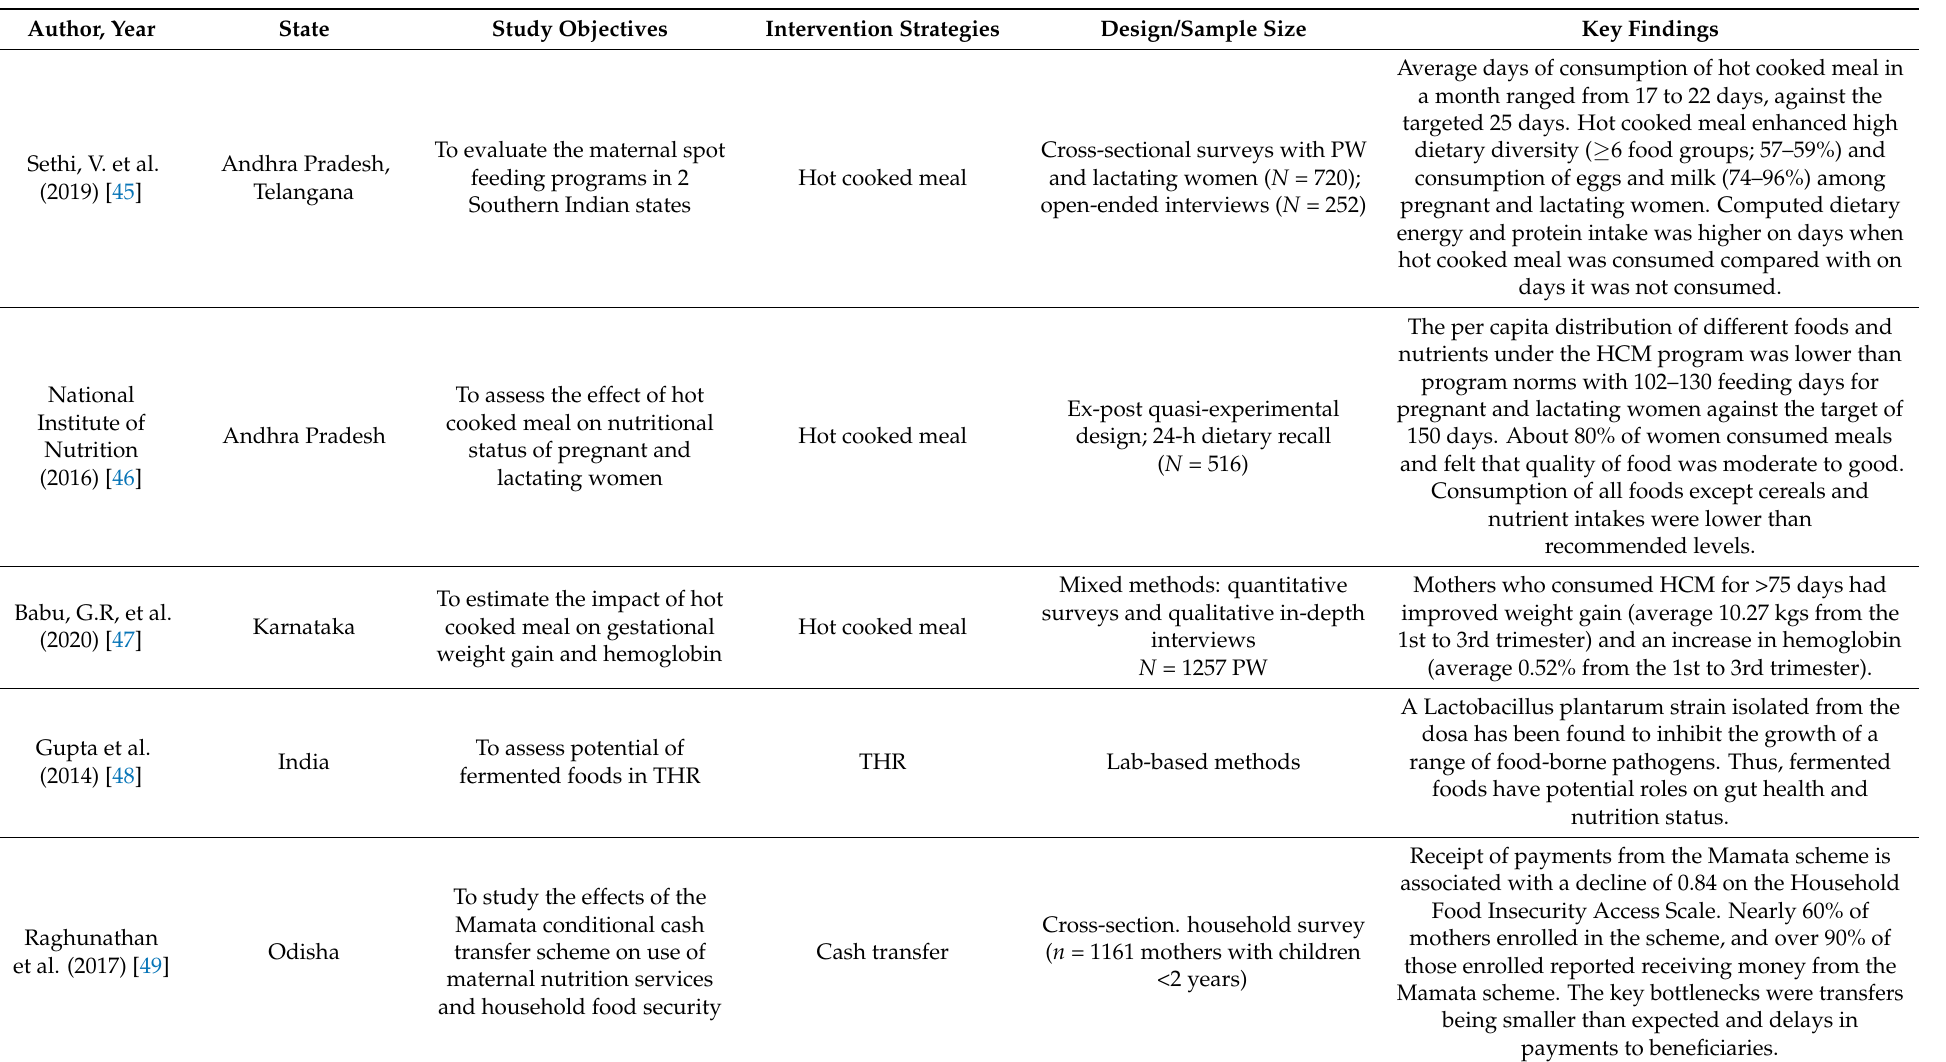
Table 4. Studies on program strategies in India to improve maternal